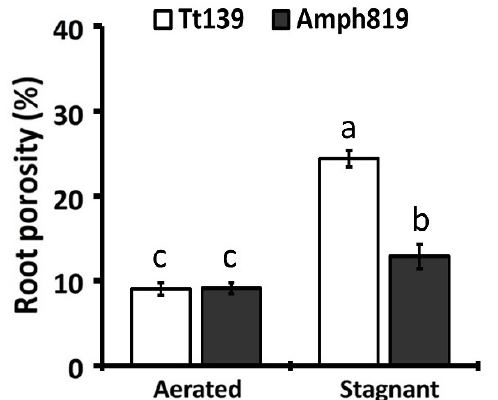
Figure 2. Root porosity (%, total gas spaces in roots) for secondary roots. Tt139 and Amph819 seedlings were grown in aerated or stagnant conditions for 2 weeks. Values are means ± SE ( n = 5). Letters indicate significant differences between means, determined using Duncan’s multiple range test (5% α ).